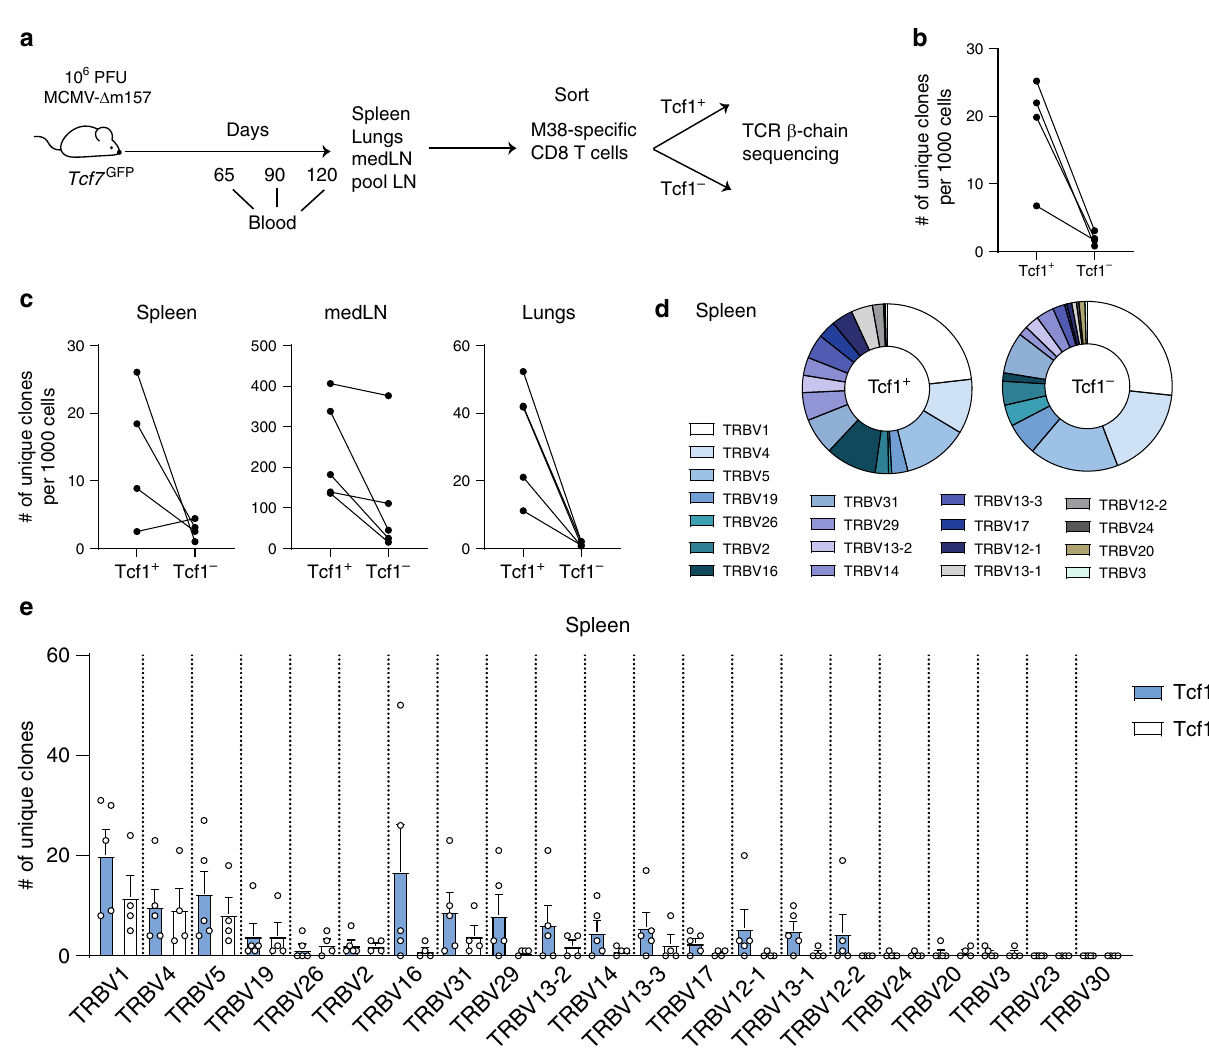
Fig. 6 M38-speci fi c Tcf1 + cells have a larger clonal diversity than the Tcf1 − cells. a Experimental setup: Tcf7 GFP mice were i.v. infected with 10 6 PFU MCMV- Δ m157. At indicated times blood was collected. At the terminal timepoint, Tcf1 + and Tcf1 − cells were sorted from the M38-speci fi c population isolated from spleen, lungs and LNs, and the TCR-V β chain repertoire was determined by next generation sequencing. b The number of unique clones, determined by unique amino acid sequence of the CDR3, per 1000 cells is shown for the Tcf1 + and the Tcf1 − M38-speci fi c population. Each line indicates an individual mouse and lines connect data from the same mouse ( n = 4). c The number of unique clones per 1000 cells is shown for the Tcf1 + and the Tcf1 − M38-speci fi c population in spleen, mediastinal LN and the lung. Each line indicates an individual mouse and lines connect data from the same mouse ( n = 4 – 5). d Pie charts indicate the composition of the M38-speci fi c population, where each colour represents the percentage of clones that uses a speci fi c TCR V- β -gene in the spleen at day 120 post-infection. Data show average percentage with n = 5 mice (Tcf1 + ) and n = 4 (Tcf1 − ). e Bar graphs represents the total number of unique clones, determined by unique amino acid sequence of the CDR3, that is found within each TCR V- β -gene in the spleen at day 120 post-infection. Data represent mean + SEM with n = 4 or 5 mice per group from one experiment. Source data are provided as a Source Data